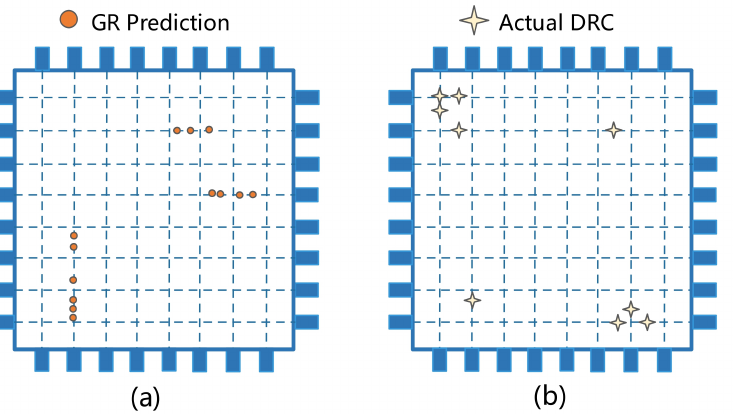
Figure 8. The mismatch between global routing congestion map and final design rule violations (DRVs) in advanced technology nodes. ( a ) Routing hotspots are predicted by global routing. ( b ) Ac- tual routing